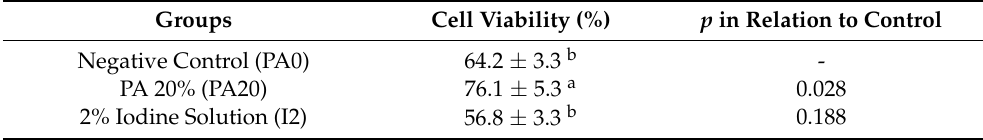
Table 2. Cell viability evaluated by the trypan blue assay of cells from domestic cat grown in vitro after 10 min incubation with 20% Jurema preta extract ( M. tenuiflora ) and 2% iodine solution.